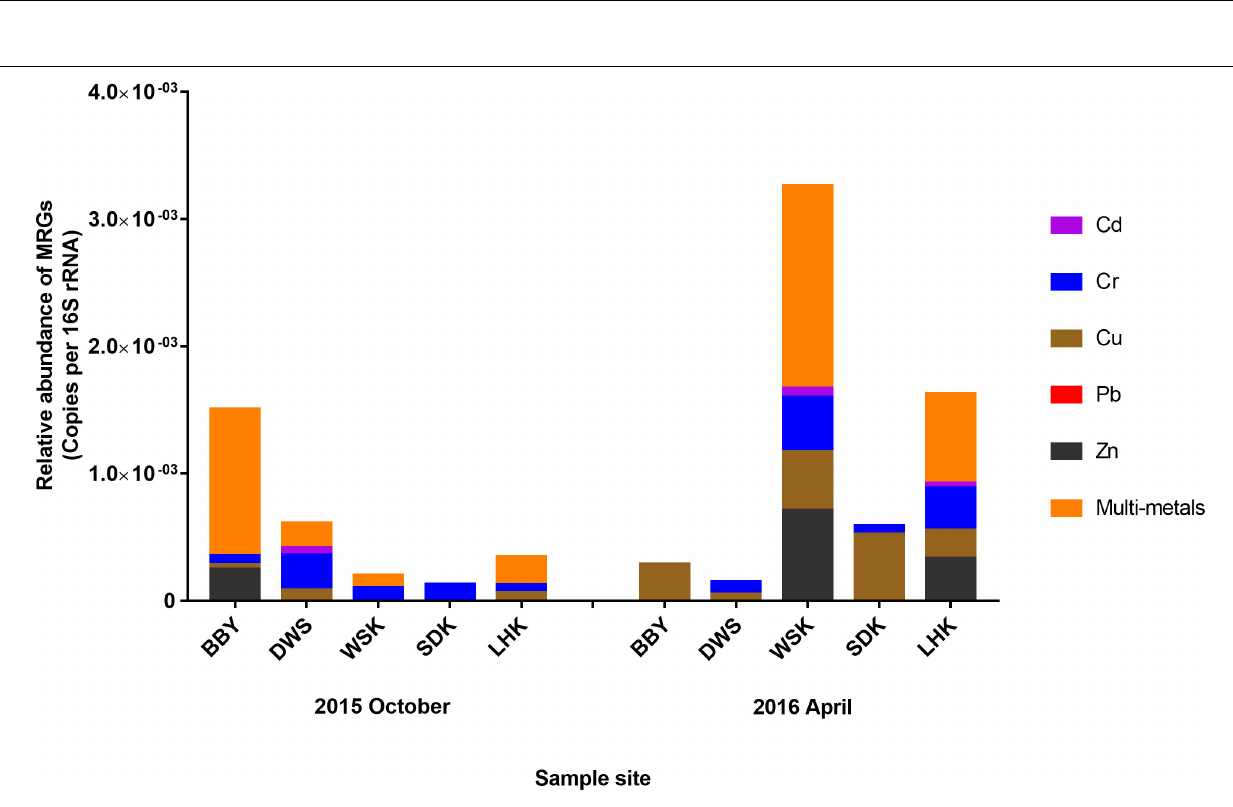
Frontiers in Marine Science |